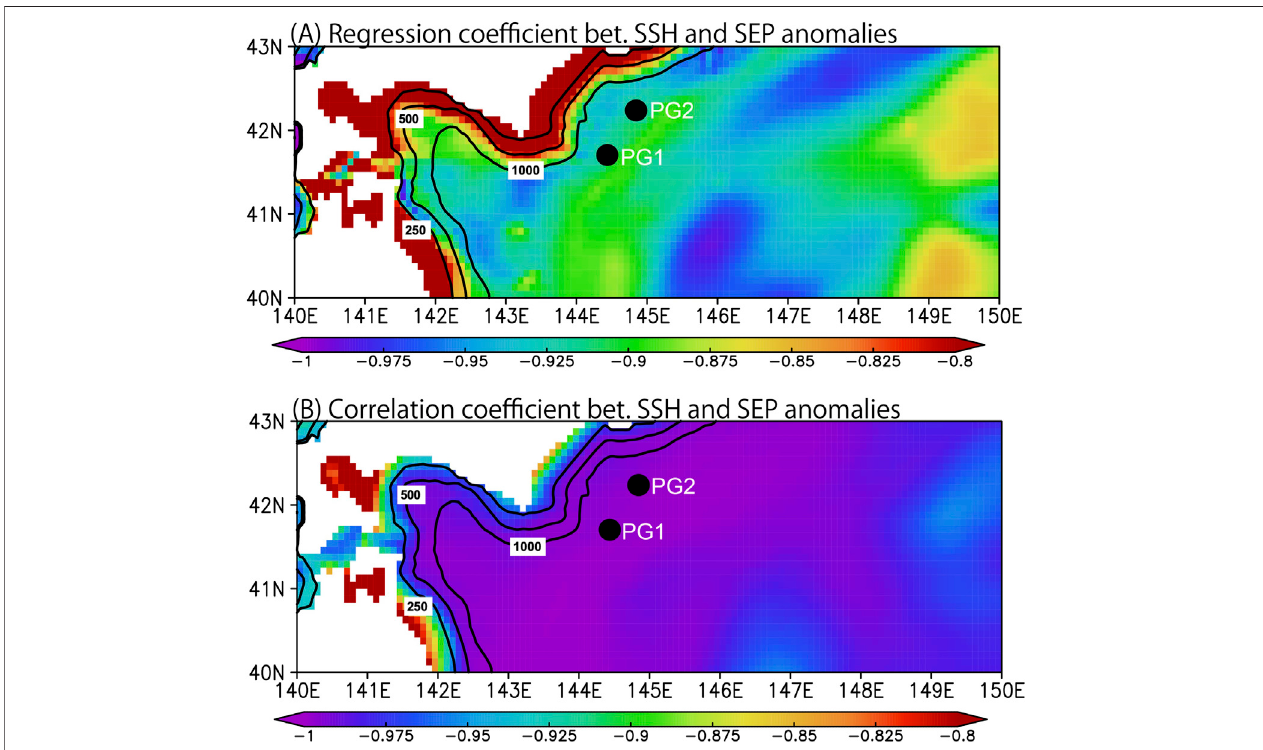
FIGURE7|(A) Spatialdistributionoftheregressioncoef fi cientbetweenSSHandSEPanomalies.Theperiodforthecalculationoftheregressioncoef fi cientisfrom August 2001 to May 2018. That is, both the start and end periods of the 15-months running mean fi lter, in which the data cannot be adequately fi ltered by the running mean fi lter, were eliminated from the original analysis period. Black solid lines show contours of bottom depths of 250, 500, and 1000 m. Black circles denote the locations of PG1 and PG2. (B) Same as (A) but for the correlation coef fi cient.